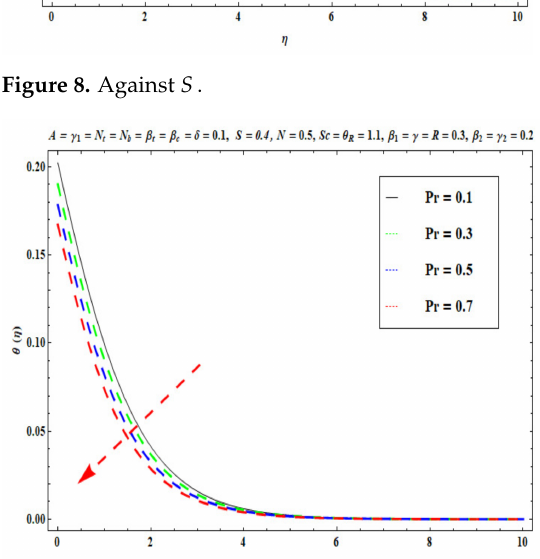
Figure 9. Against